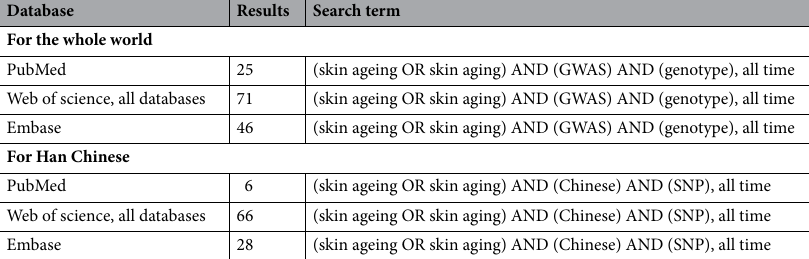
Table 1. Search terms used to search for SNPs associated with skin ageing